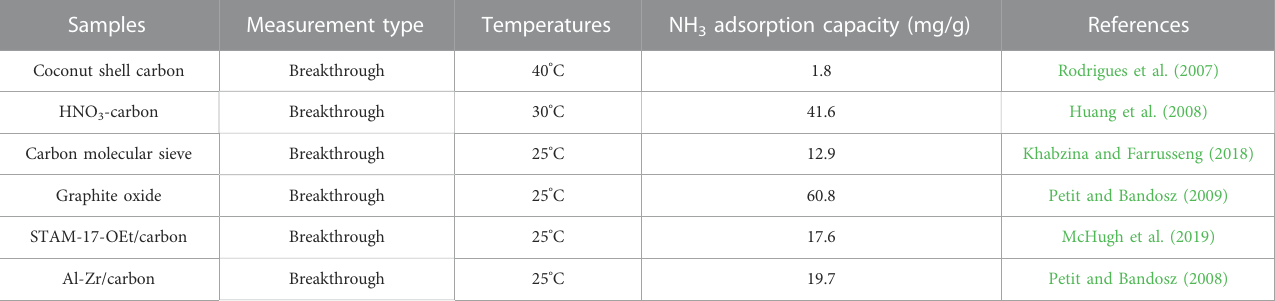
TABLE 1 The NH 3 adsorption capacity over different carbon materials in the literatures.